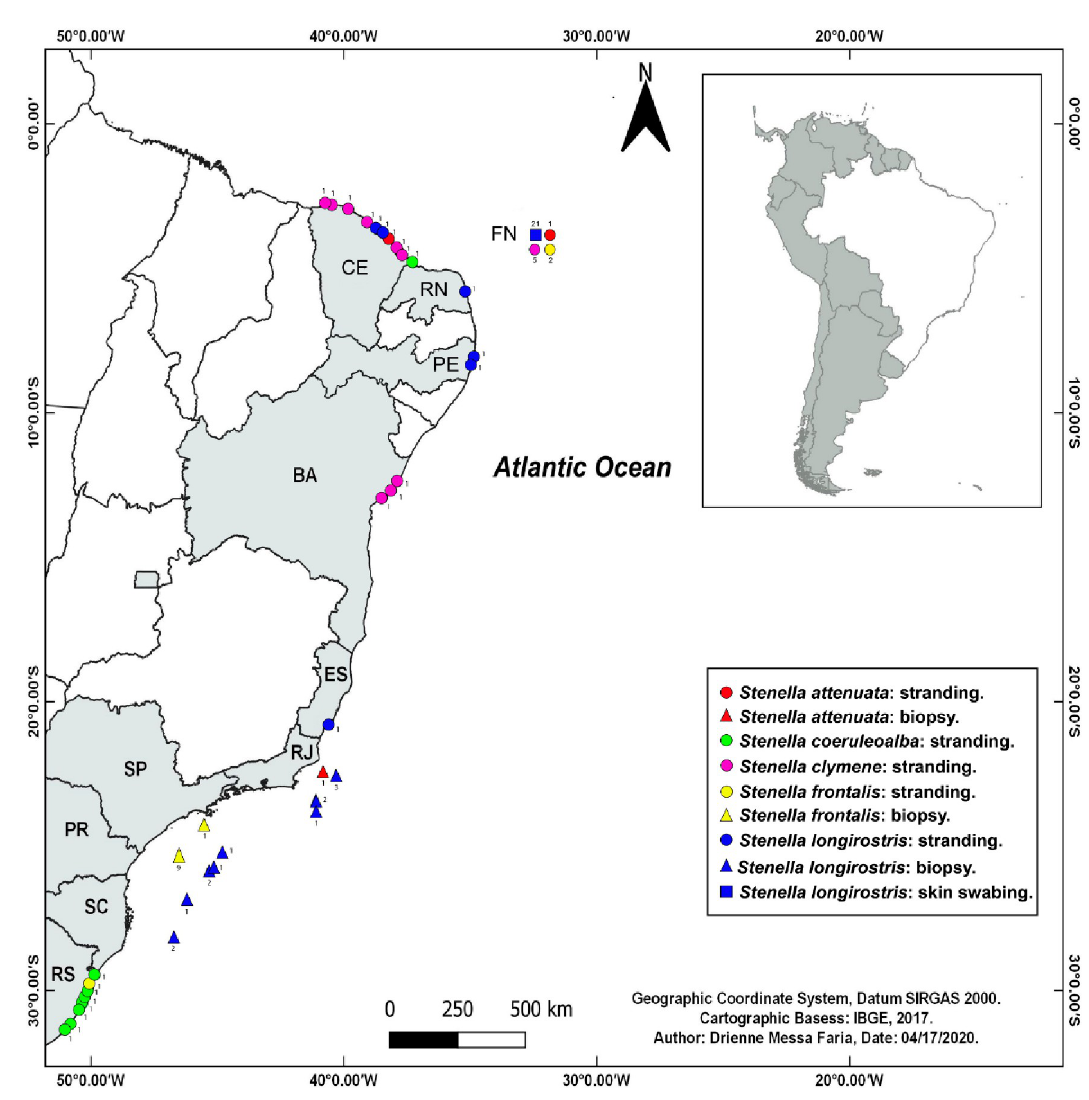
Fig 1. Locations where Stenella samples were obtained on the Brazilian waters. In gray, sampled states: CE: Ceara´; FN: Fernando de Noronha; RN: Rio Grande do Norte; PE: Pernamuco; BA: Bahia; ES: Espı´rito Santo; RJ: Rio de Janeiro; SP: S ã o Paulo; PR: Parana´; SC: Santa Catarina; RS: Rio Grande do Sul. This map was made using the QGIS software (QGIS.org, 2021; QGIS Geographic Information System; QGIS Association; http://www.qgis.org).